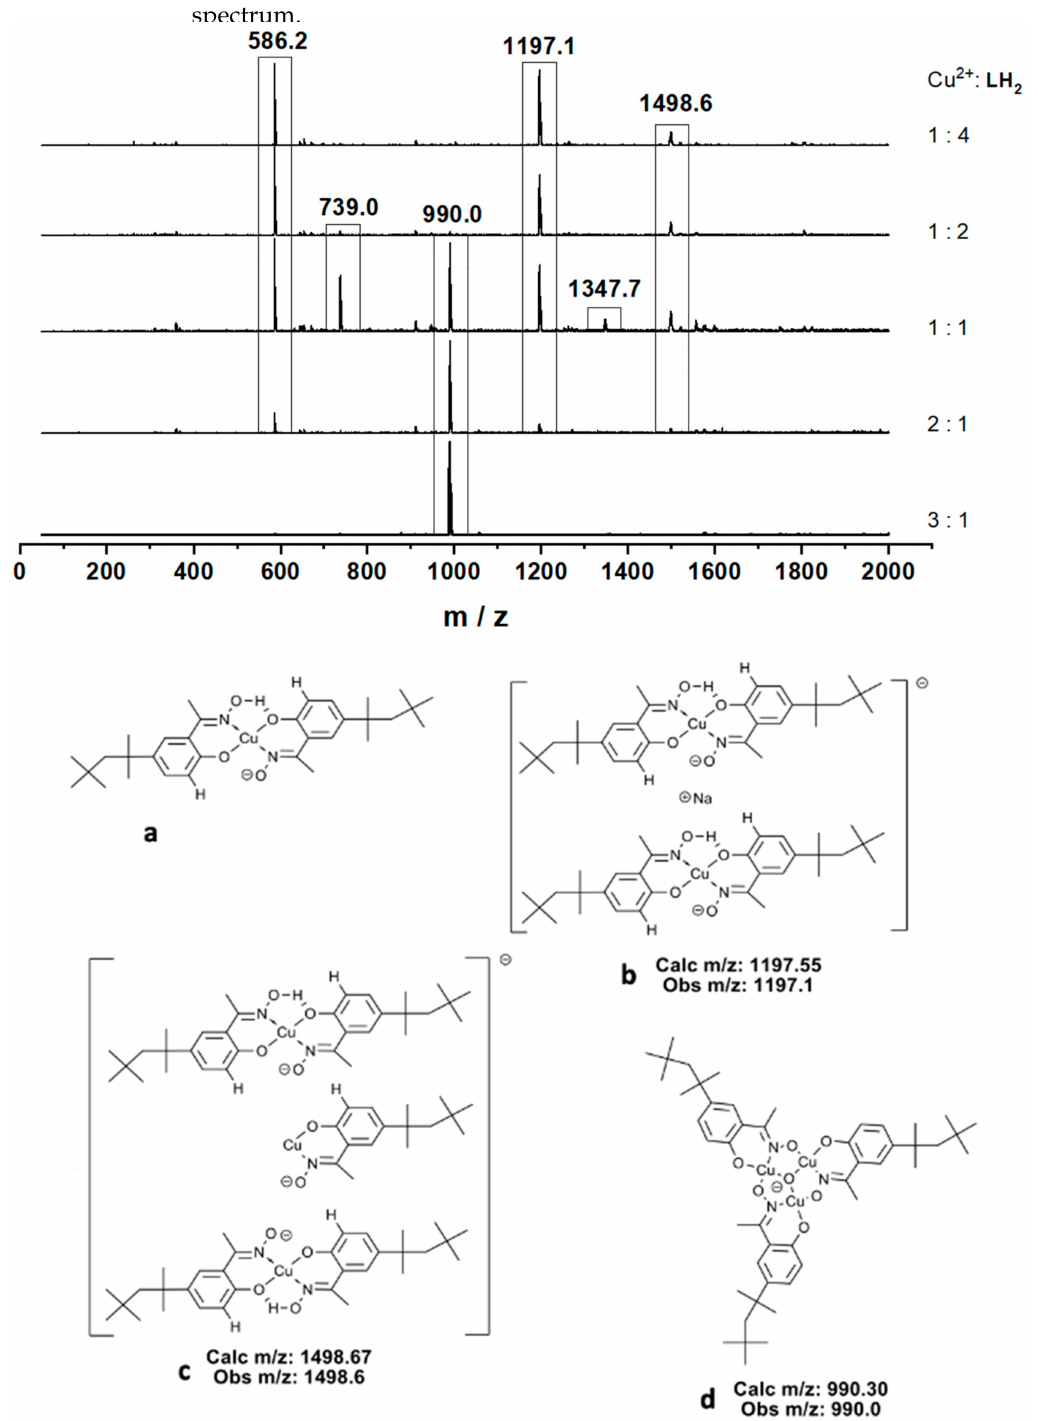
Figure 6. Suggested structures, together with their observed and calculated monoisotopic masses, for the dominant monoanionic species ( a – d ) in an acetonitrile solutions with different Cu(II):L 4 H 2 molar